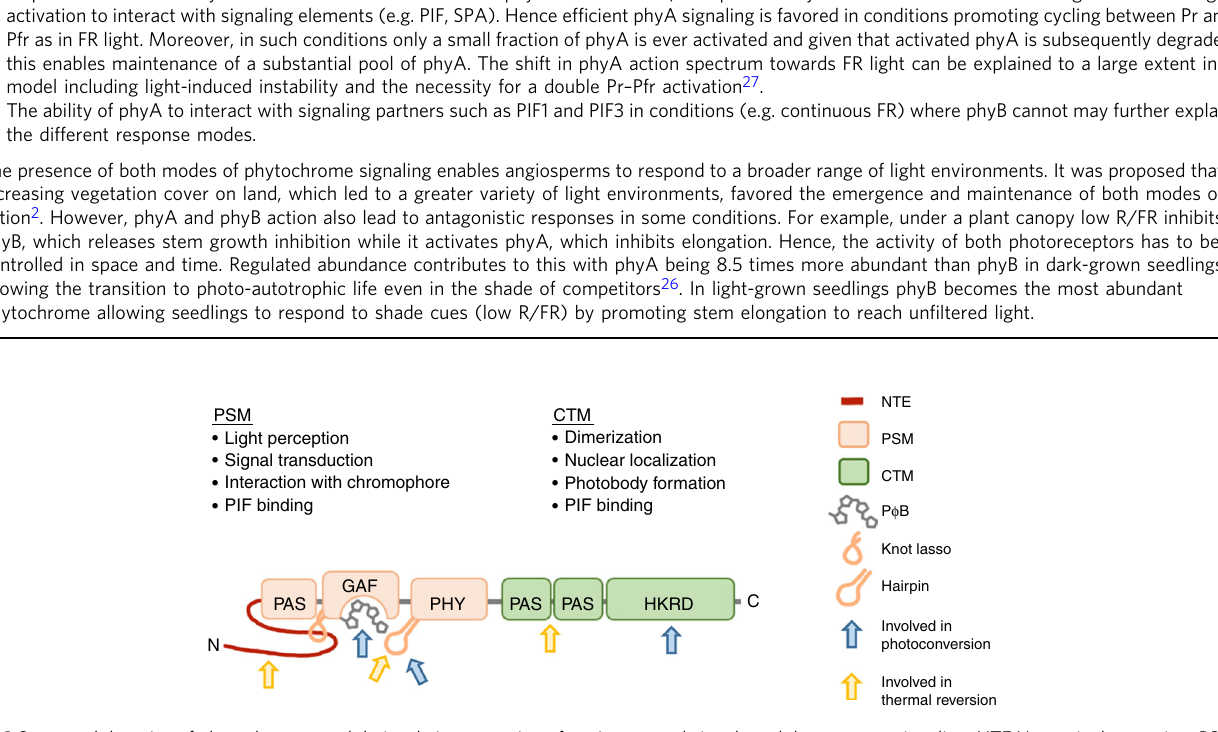
Fig. 2 Structural domains of phytochromes and their role in perception of environmental signals and downstream signaling. NTE N-terminal extension, PSM photosensory module, CTM C-terminal module. Modi fi ed from Burgie et al.